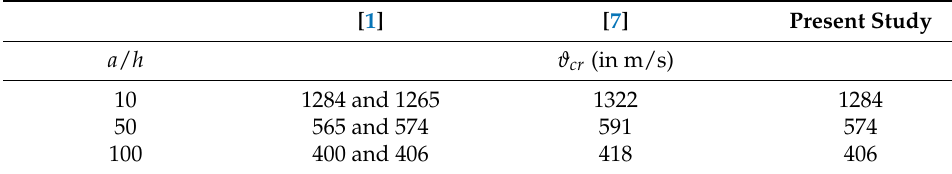
Table 2. Comparisons of d Q (cid:54) = 0